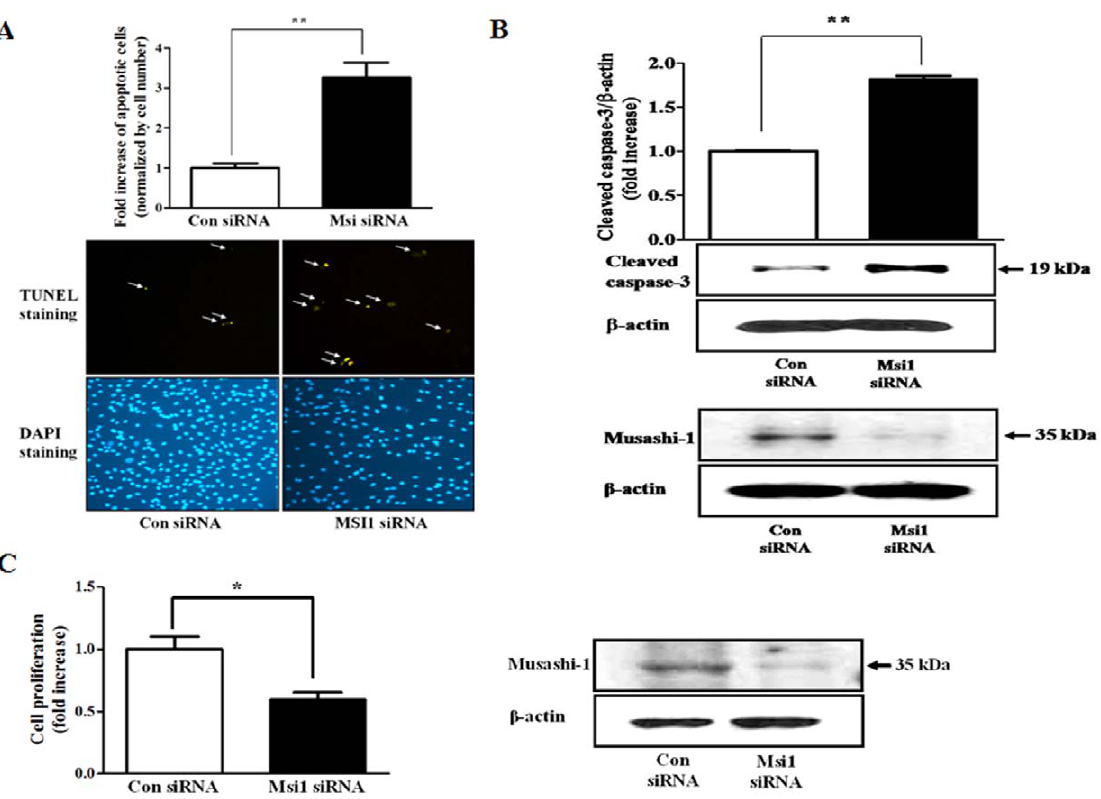
Figure 3. The effects of Msi1 knockdown on cell proliferation and apoptosis. After preculture for 24 h, hUCB-MSCs were transfected with 50 nM Msi1 siRNA for 48 h. The transfection of 50 nM Msi1 siRNA efficiently reduced Msi1 protein levels. The transfection of 50 nM Msi1 siRNA also significantly increased the number of TUNEL-positive cells ( A ), as well as the expression level of activated caspase-3 ( B ), compared with the controls. ( C ) The transfection of 50 nM Msi1 siRNA significantly increased cell proliferation compared to controls. The blue staining (DAPI) identifies cell nuclei. b -actin was used as an internal control. The results are shown as the mean 6 SD from three independent experiments. * P , 0.05, ** P , 0.01, and *** P , 0.001.